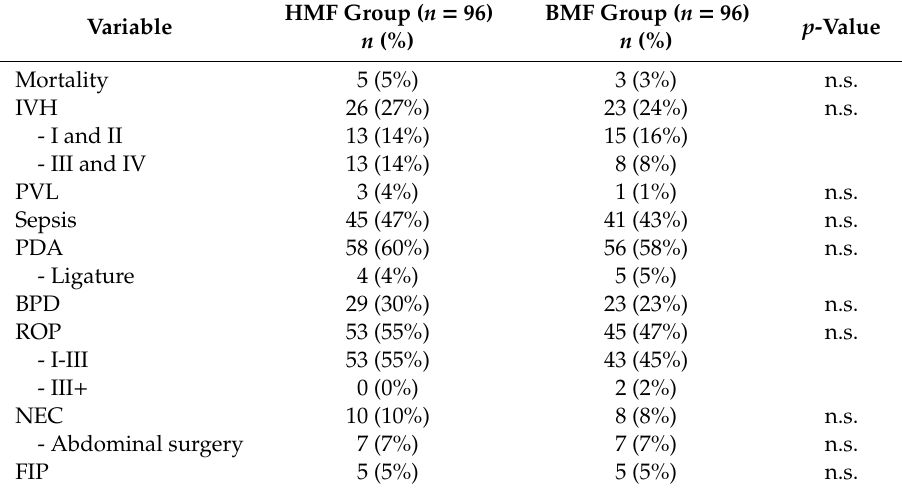
Table 6. Morbidity and Mortality of the study